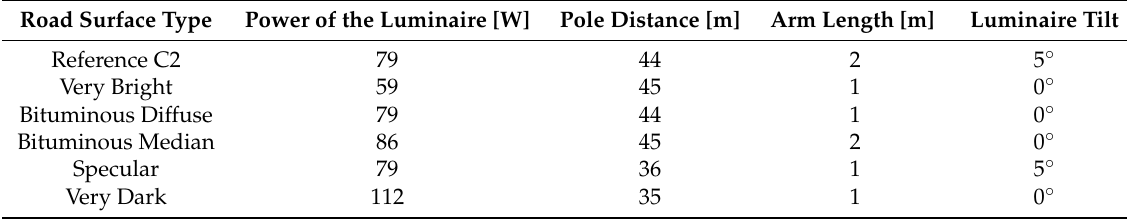
Table 6. Optimized pole distance and luminaire position for Case B.